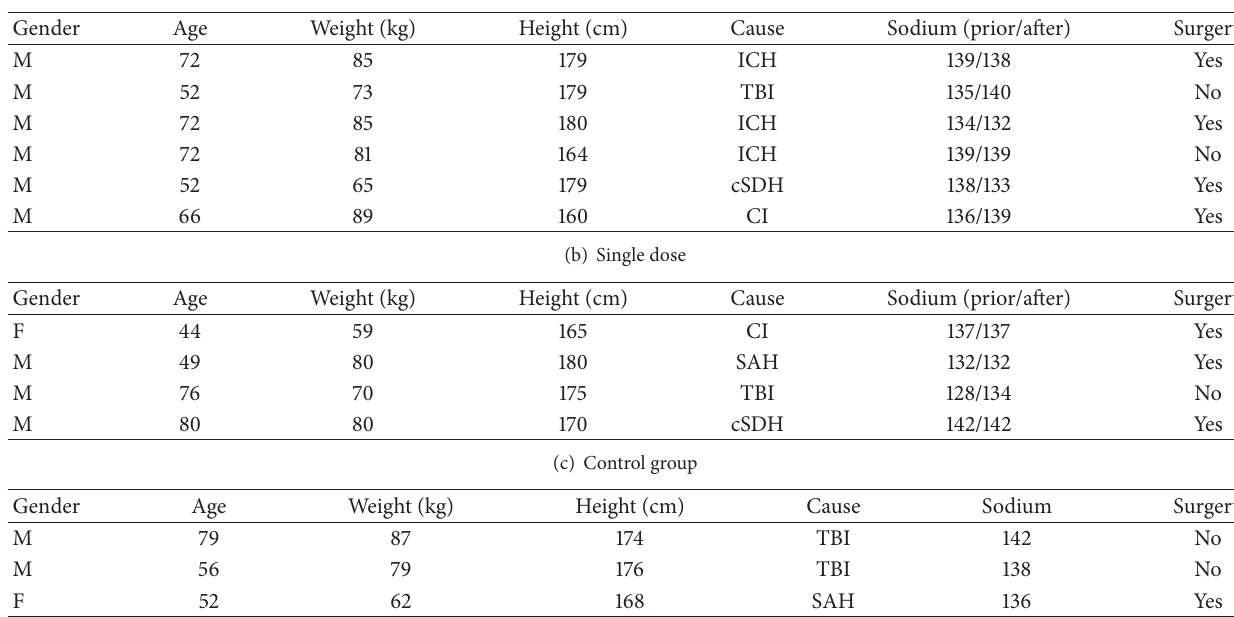
Table 1: Characteristics of the patient population. Cerebral infarction = CI, spontaneous subarachnoid haemorrhage = SAH,